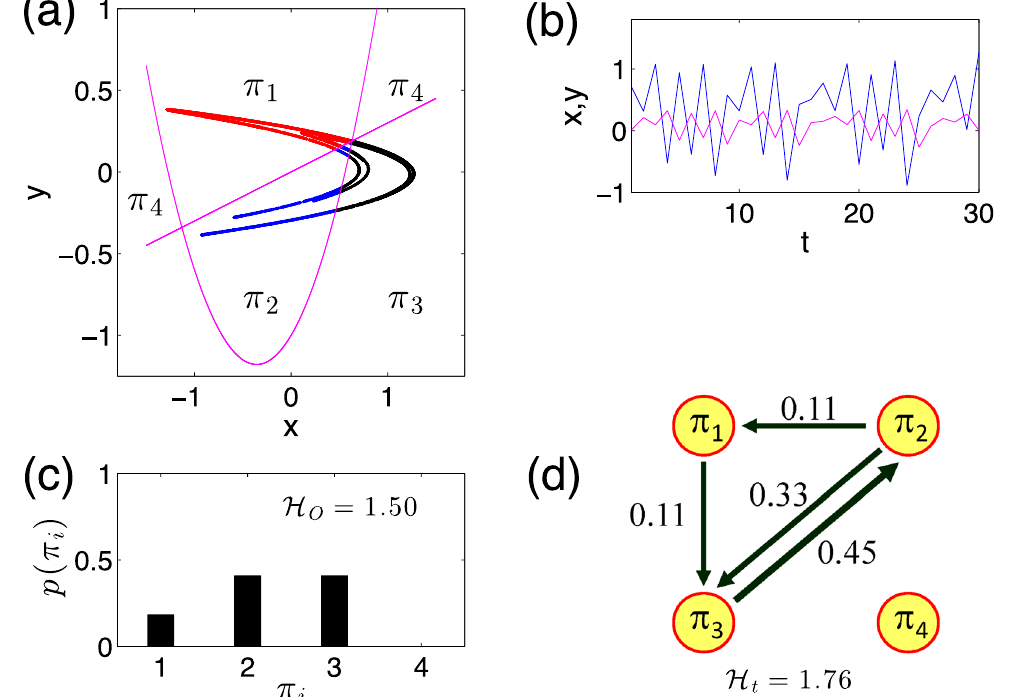
Figure 5. Hénon map: ( a ) attractor, ( b ) segments of time series, ( c ) histogram of order patterns leads to = . 1 5  , and ( d ) ordinal pattern transition network removing self-loops which yields  = . 1 76 O